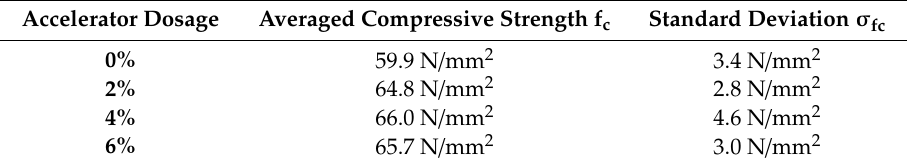
Table 4. 28d compressive strength f c of 3D-printed specimens.